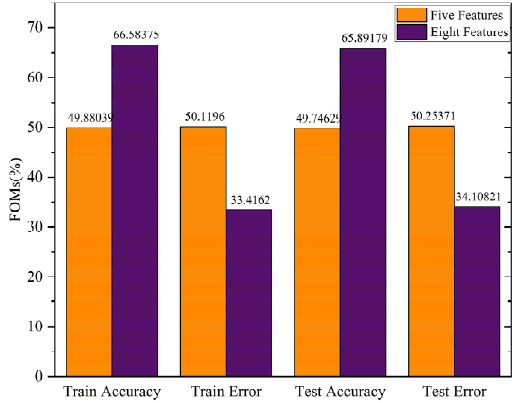
Figure 4. Effect of feature selection on FOMs (%).